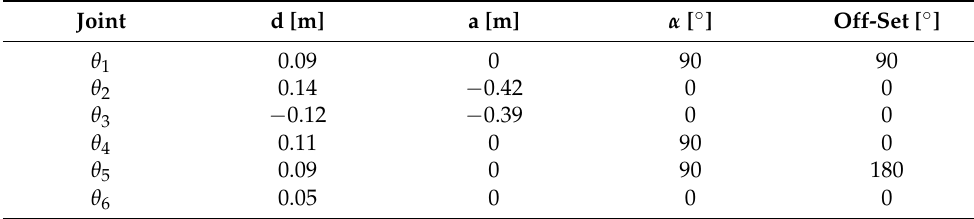
Table 4. DH parameters of the UR5e robot (see definitions given in Table 3).